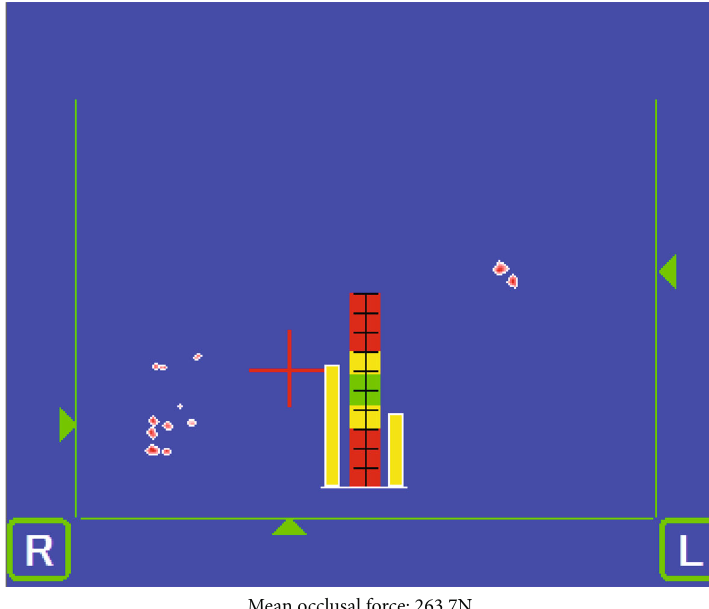
Mean occlusal force: 263.7N Figure 1: Occlusion state at initial visit.